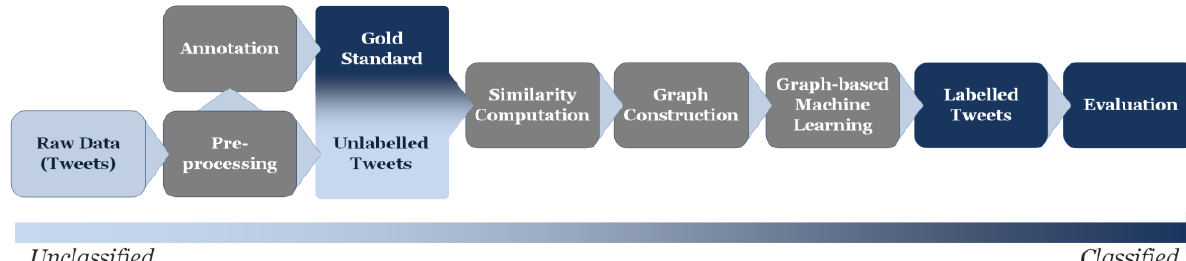
Figure 1. Workflow of the method for extracting emotions from unedited